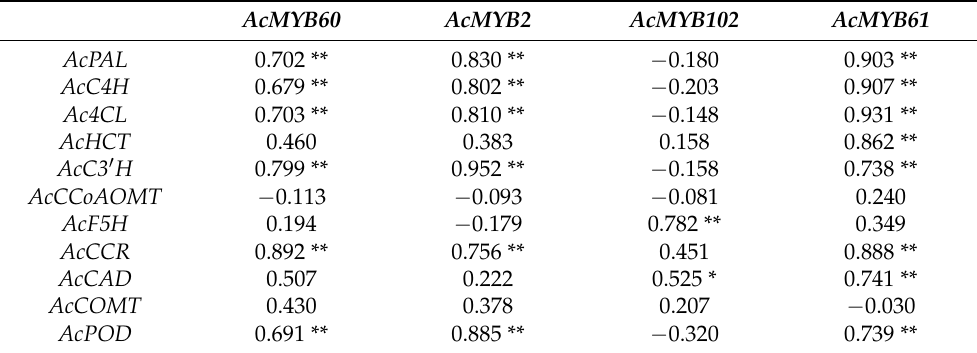
Table 3. Correlation between expression level of AcMYBs and lignin-biosynthesis-related genes under different